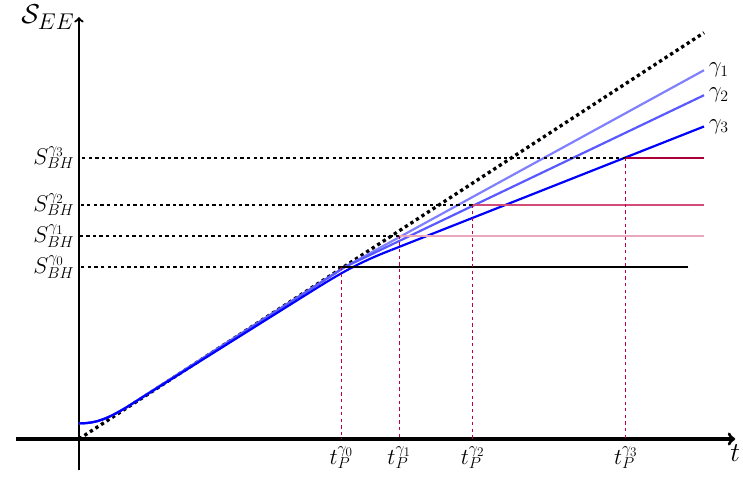
Figure 6 . We have depicted the Page curves for the parameters 0 < (cid:13) 1 < (cid:13) 2 < (cid:13) 3 < 1 = p 2. (cid:13) 0 here refers to the (cid:13) = 0 Page curve in the BTZ